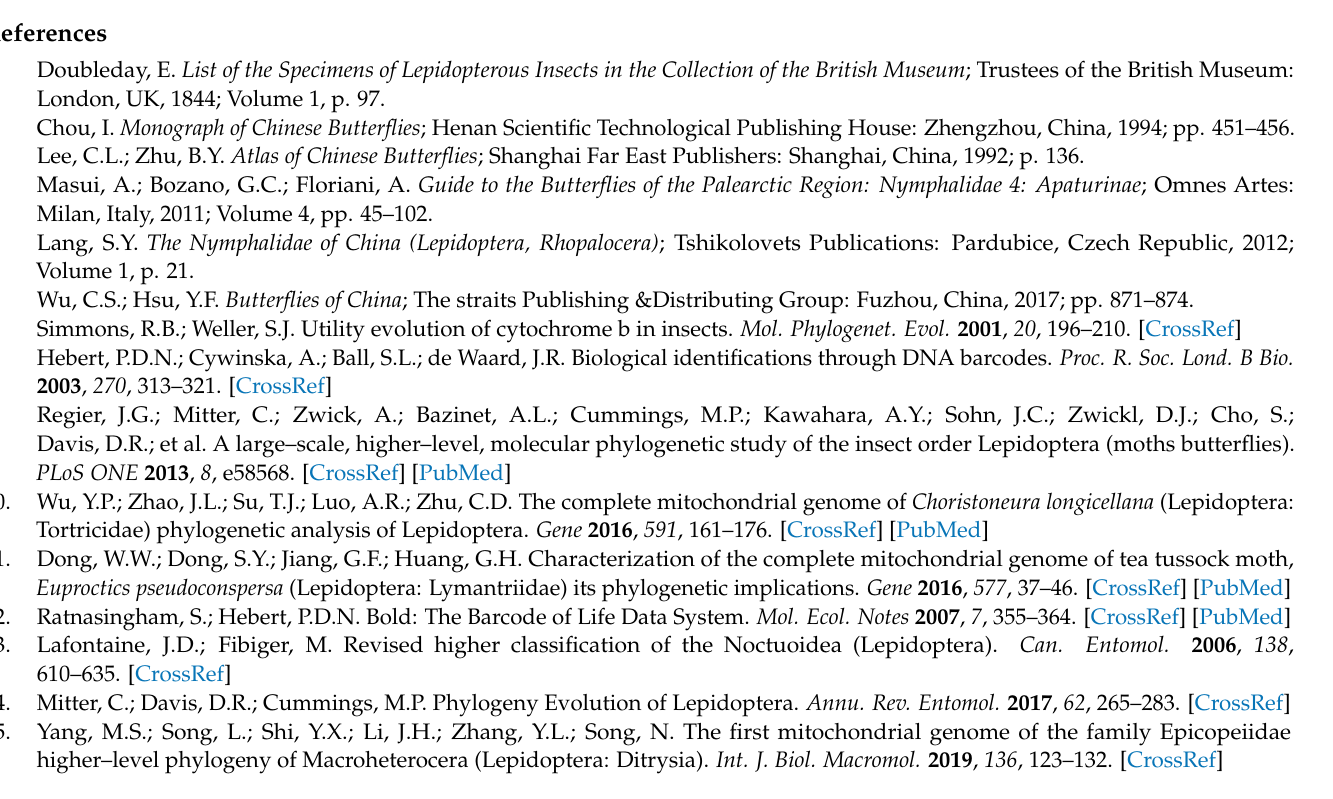
Figure S2: phylogenetic relationships by ML analysis based on the 13PCGs. Table S1: sequences of 22 pairs of primers. Table S2: list of species used to construct the phylogenetic tree. Table S3: the starting partitions used to initiate the PartitionFinder analysis. Table S4: evolutionary models from partition strategies start scheme used in the phylogenetic analysis. Table S5: bias of base composition of protein-coding genes in the two mitogenomes. Table S6: codon usage of protein genes of twelve mitogenomes in